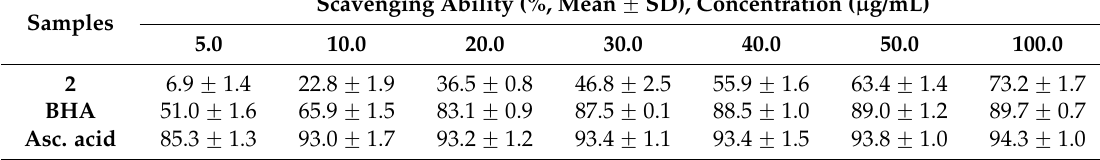
Table 4. Radical scavenging activity of 2 .